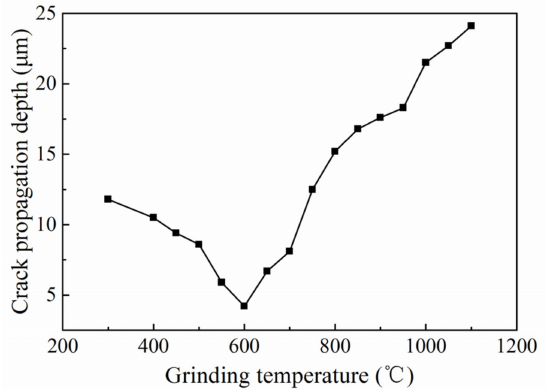
Figure 8. Crack propagation depth at different grinding